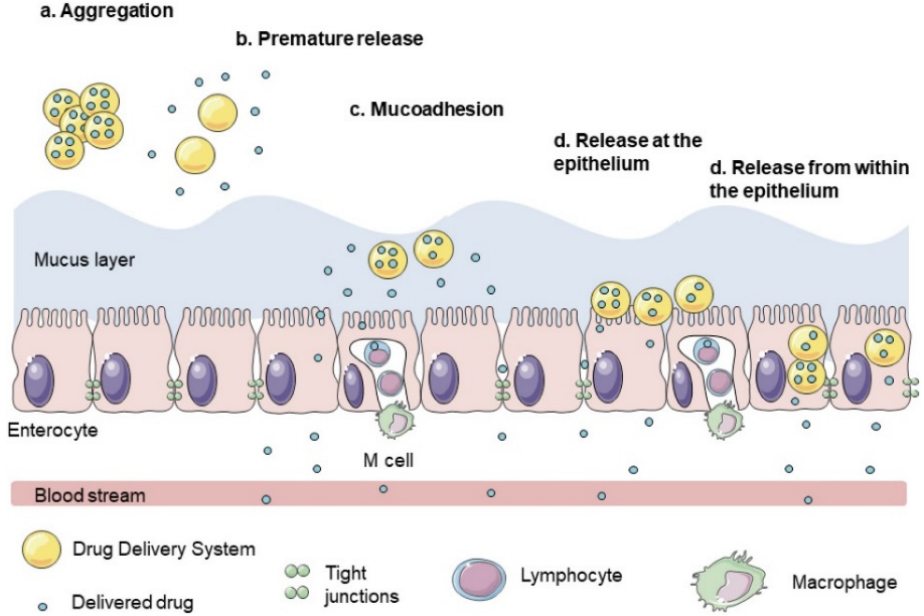
Figure 5. Barriers to the colonic transport of drugs. Reprinted by permission from John Wiley and Sons [103]. Copyright